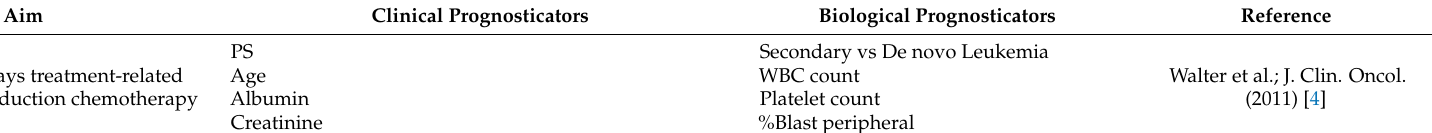
Table 1. Prognostic algorithms for fitness